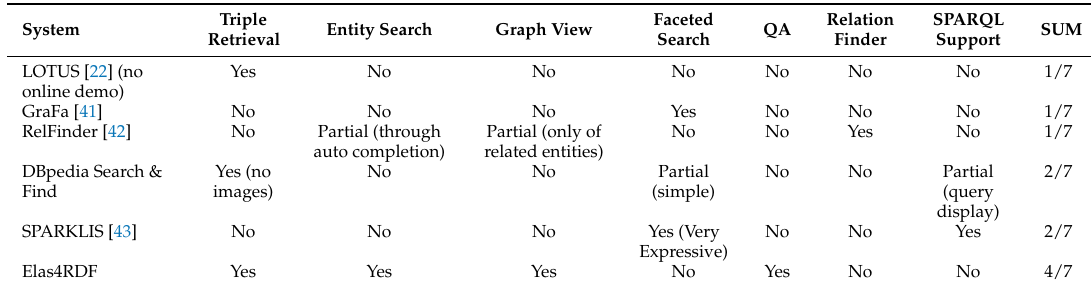
Table 1. Search Systems over DBpedia.